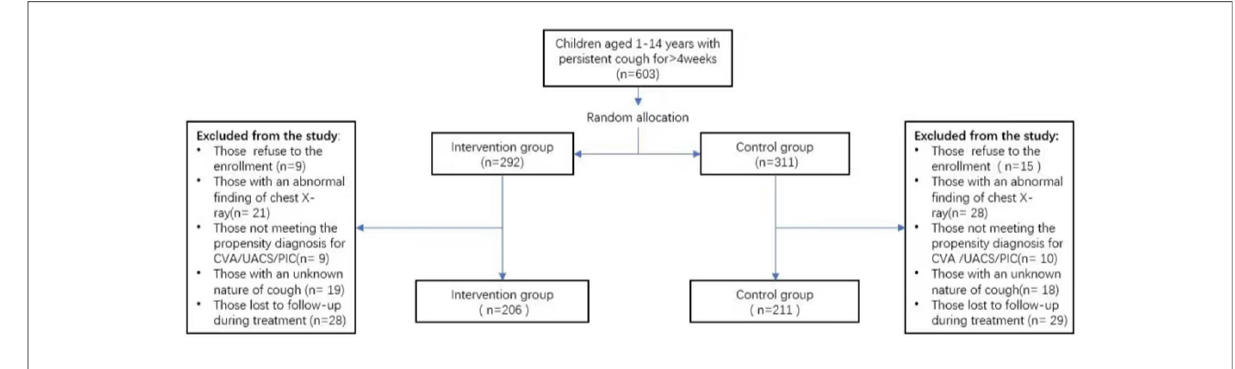
FIGURE 3 Flowchart of case screening and